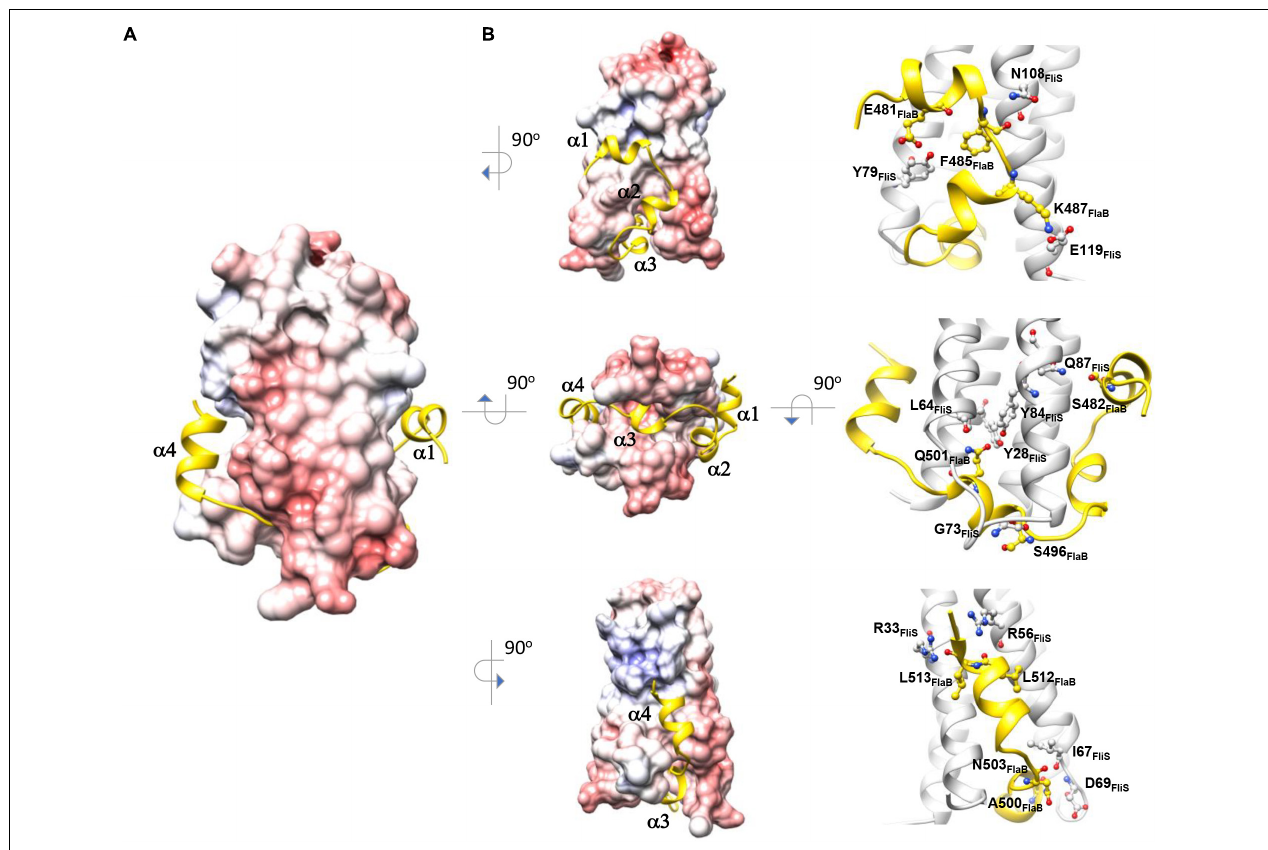
FIGURE 2 | Molecular interaction of FliS and FlaB C . (A) The molecular surface of FliS is colored according to the electrostatic potential, with a contour level of ± 10 kT. FliB C is represented as a cartoon and colored in yellow. (B) The three interfaces of FliS-FliB C are drawn. Residues that form interactions via salt bridges and hydrogen bonds are